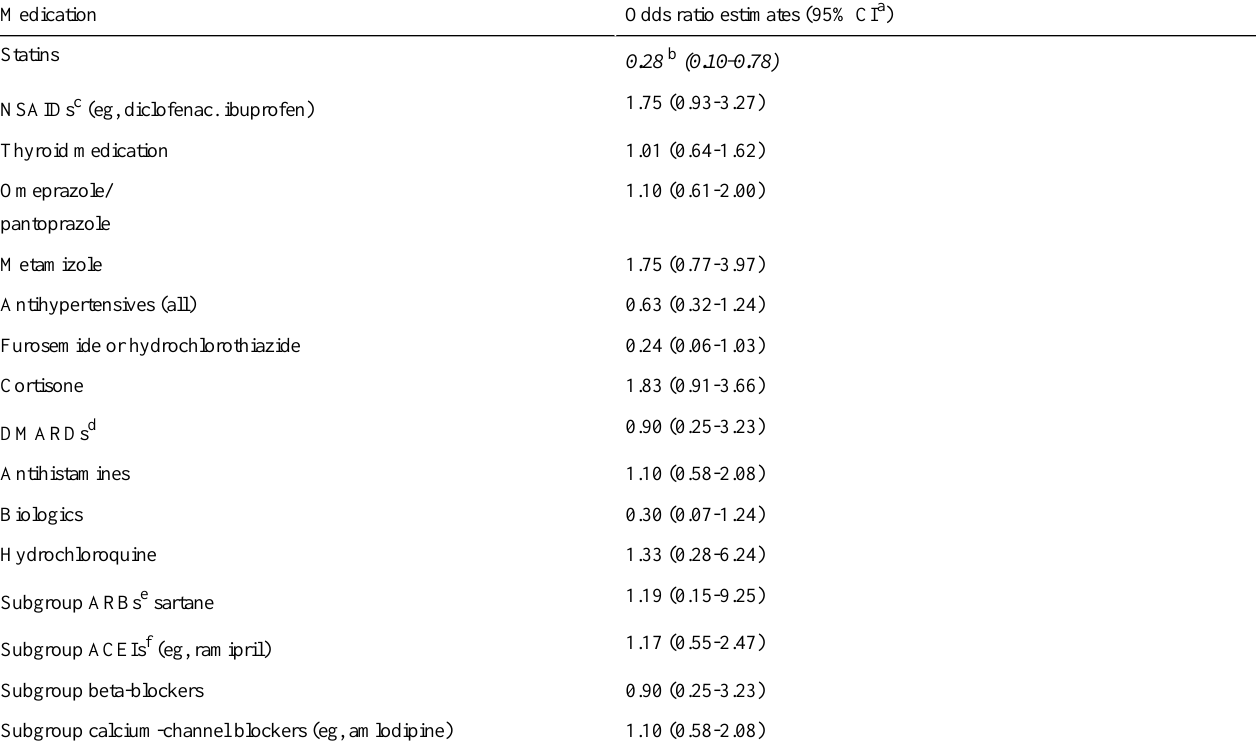
Table 4. Strength of association between statins and presumed COVID-19 diagnosis based on a positive reverse transcription polymerase chain reaction test (n=16) or presence of symptoms (minimum 4 out of 7 typical symptoms,